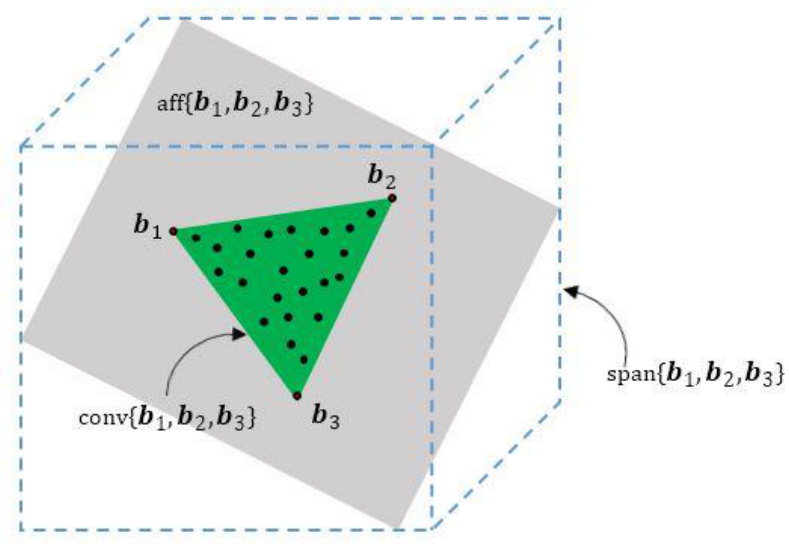
Figure 2. Affine hull and convex